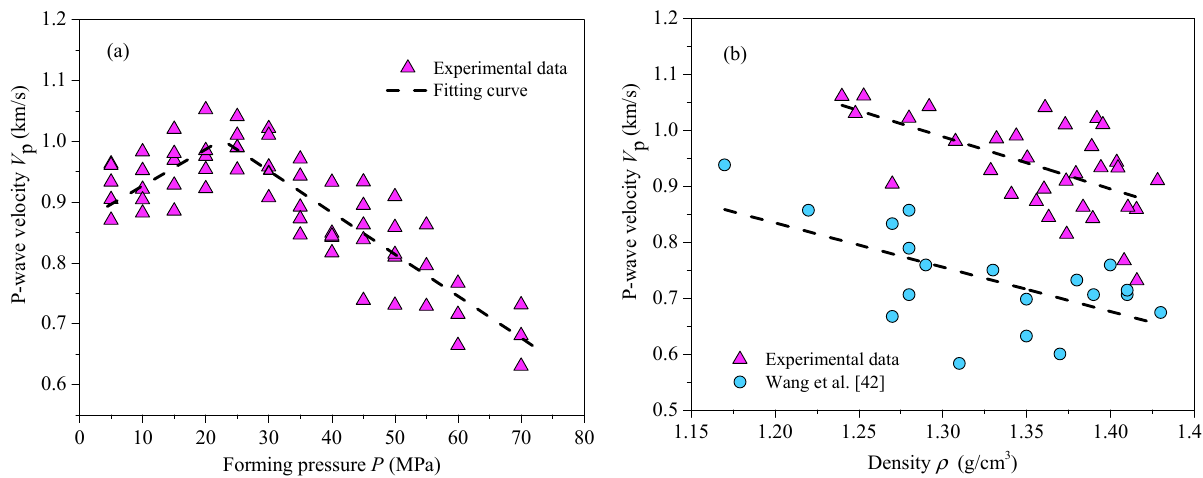
Figure 8. Relationship between P-wave velocity and forming pressure of RTC. (a) P-wave velocity vs. forming pressure; (b) P-wave velocity vs. density.